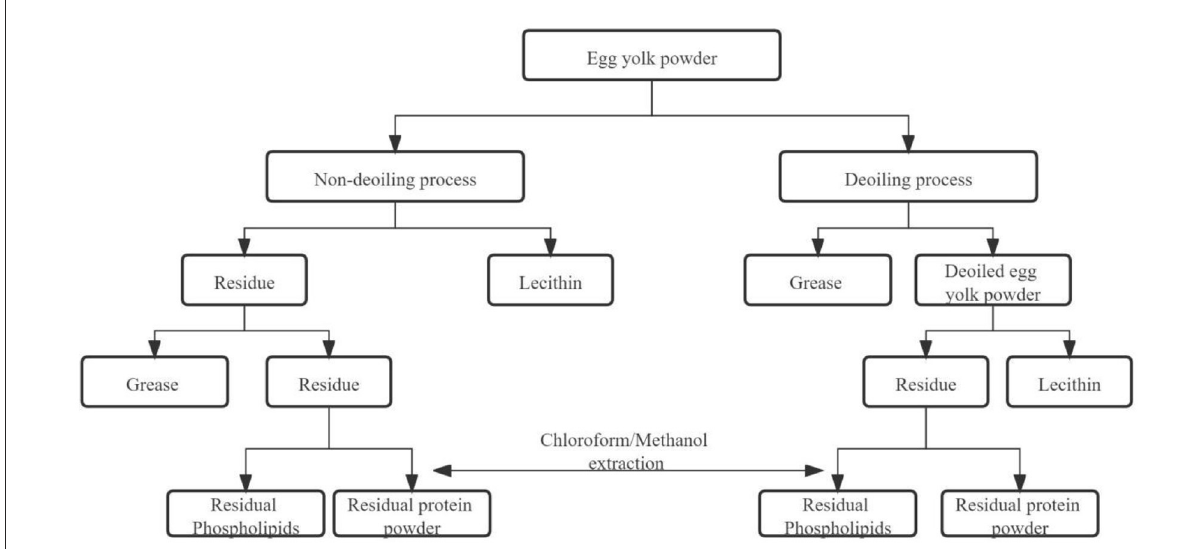
FIGURE1 Process of leclithin by drying egg yolk powder as a raw solvent.